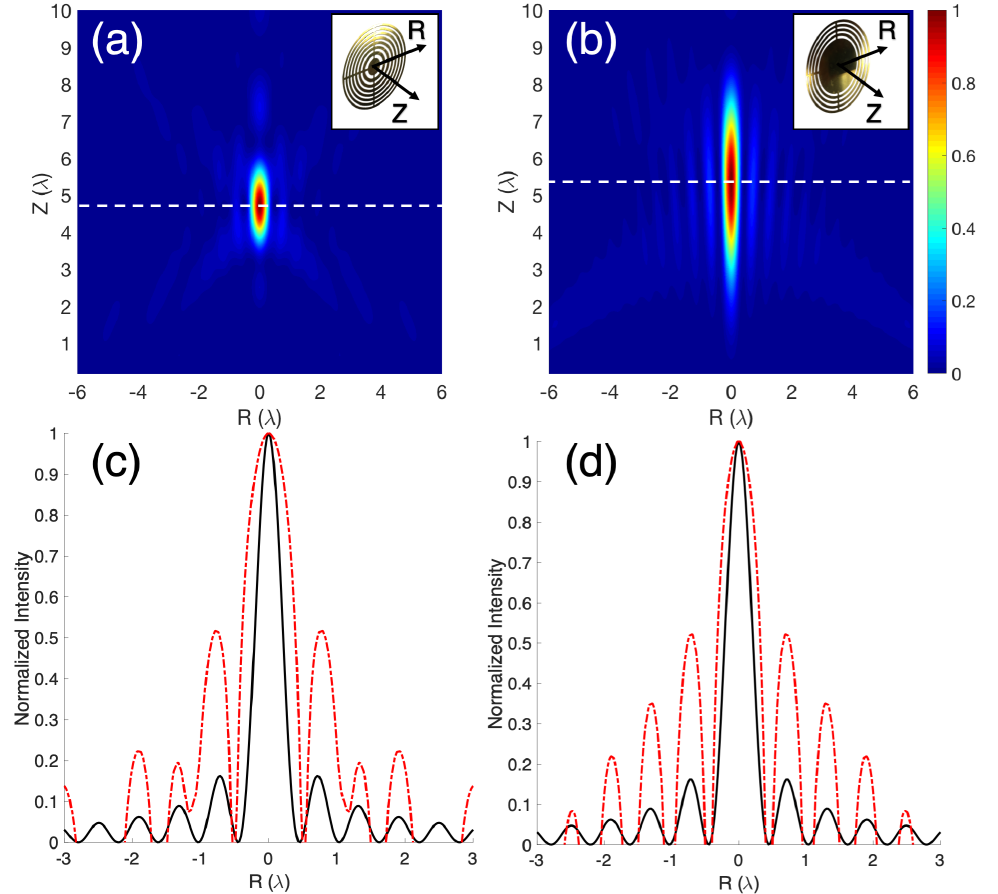
Figure 1. Self-normalized intensity maps to the maximum with the R - and the Z -axis normalized to λ for ( a ) a Soret Zone Plate (SZP) and ( b ) an SZP with amplitude Pupil mask (PSZP). Normalized intensity level focus transversal cuts from intensity maps (red dashed line) are compared to the Bessel J 2 function (black solid line) for ( c ) SZP and ( d ) 0